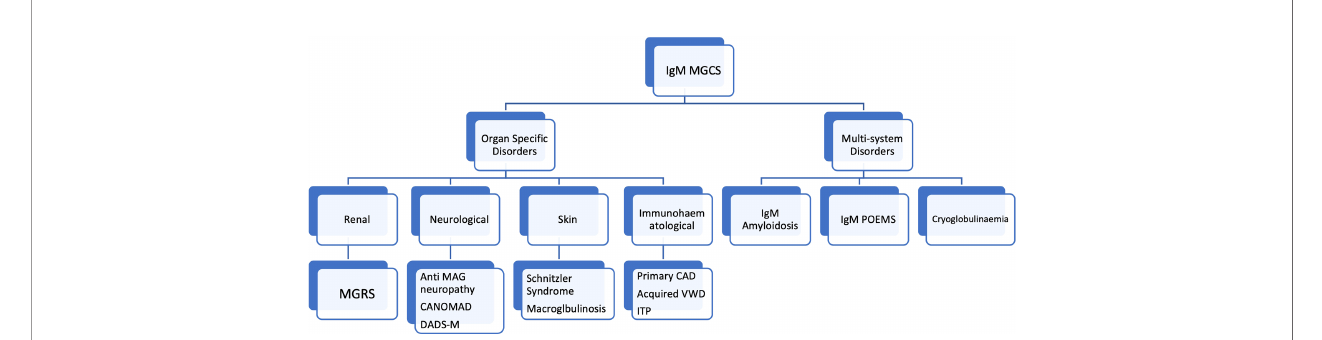
FIGURE 2 | Classi fi cation of of IgM monoclonal gammopathy of clinical signi fi cance entities. MGCS, monoclonal gammopathy of clinical signi fi cance; MGRS, monoclonal gammopathy of renal signi fi cance; POEMS, Polyneuropathy, Organomegaly, Endocrinopathy, Monoclonal gammopathy and Skin abnormalities; CANOMAD, Chronic Ataxic Neuropathy, Ophthalmoplegia, IgM paraprotein, Cold Agglutinins, Disialosyl antibodies; DADS-M, Distal acquired demyelinating symmetric neuropathy. MAG, Myelin associated glycoprotein. CAD, Cold agglutinin disease, VWD, Von Willebrand disease, ITP, Immune